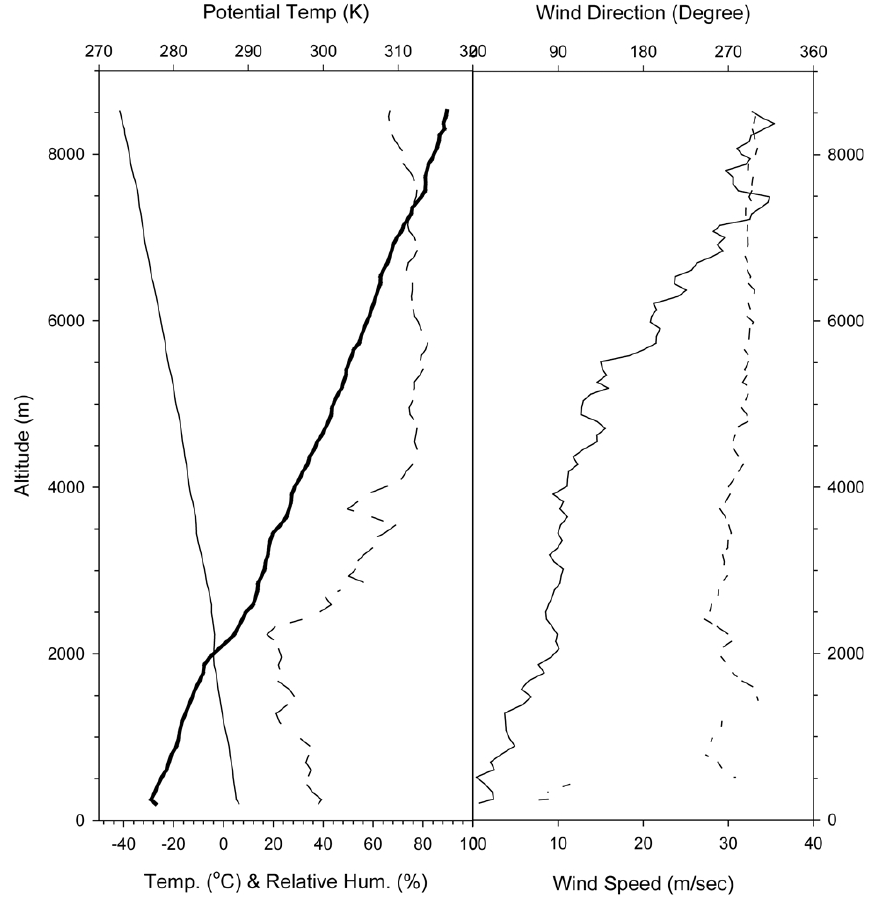
Fig. 4. Vertical profiles of meteorological parameters measured by the OPC sonde, 19 April 2008. (a) Temperature (thin line), potential temperature (heavy line), and humidity (dashed line), and (b) wind speed (solid line) and direction (dashed line) profiles observed with meteorological